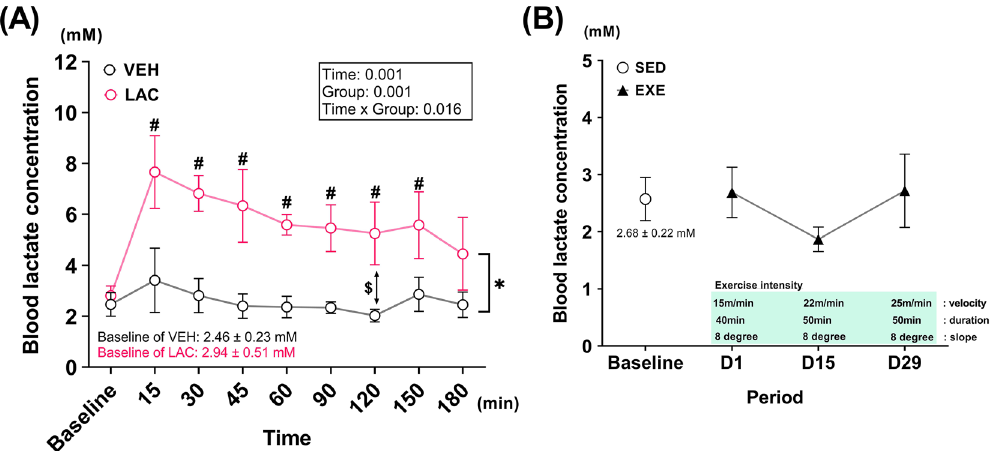
Figure 1. Blood lactate concentration was sufficiently elevated by oral administration of lactate and not by mild exercise. ( A ) Blood lactate concentration after oral administration of 3 g/kg lactate over time (VEH, saline administration group, n = 4; LAC, lactate administration group, n = 6). Data were analyzed using two- way repeated ANOVA with Student’s t -test between groups for post hoc test and paired t -test for comparison in baseline and a timepoint within group. ( B ) Blood lactate concentration immediately after mild-intensity exercise training over period ( n = 8 per group; SED, sedentary group; EXE, exercise training group). For comparison within EXE, one-way repeated ANOVA was used, and comparison between SED and a timepoint of EXE was performed using independent Student’s t -test. D1, experimental day 1; D15, experimental day 15; D29, experimental day 29; # p < 0.05, baseline vs time point within group; * p < 0.05, VEH vs LAC at the same time point except baseline; $ p = 0.01, VEH vs LAC analyzed by Mann–Whitney test. Data are presented as the mean ± standard